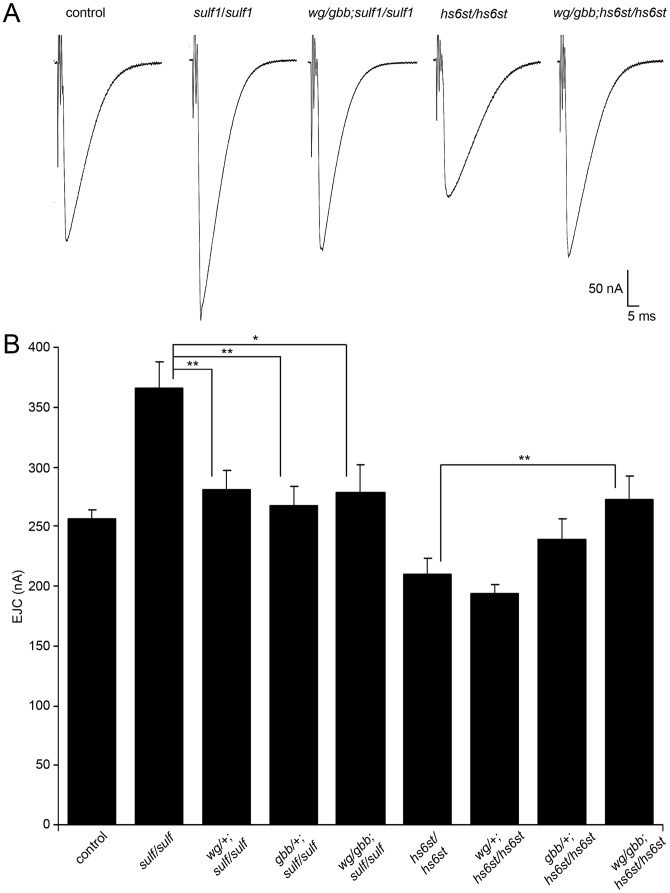
WNT and BMP signals genetically interact with sulf1 and hs6st nulls.Genetic reduction of Wg and Gbb levels in sulf1 and hs6st homozygous conditions restore EJC amplitudes to control levels. (A) Representative excitatory junctional current (EJC) traces from control (w1118), homozygous sulf1Δ1 null, heterozygous wg/+ and gbb/+ in sulf1 null background (wgI-12/gbb2; sulf1Δ1/sulf1Δ1), homozygous hs6std770 null and heterozygous wg/+ and gbb/+ in hs6st null background (wgI-12/gbb2; hs6std770/hs6std770). The nerve was stimulated (arrows) in 1.0 mM external Ca2+, and TEVC records (−60 mV holding potential) made from muscle 6 in segment A3. Each trace was averaged from 10 consecutive evoked EJC recordings. (B) Quantified mean EJC amplitudes (nA) for the nine genotypes shown. Sample sizes are ≥7 animals per indicated genotype. Statistically significant differences calculated using student's t-test, * p<0.05, ** p<0.01. Error bars indicate S.E.M.